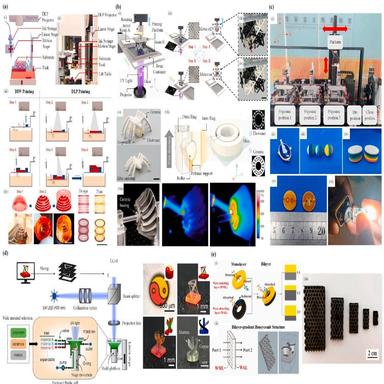
DLP-based multi-material ceramic additive manufacturing equipment and technologies: (a) multi-material 3D printing equipment integrating DLP and DIW technologies along with the printed multi-color structural parts, (b) DLP-based centrifugal multi-material 3D printing technology and heterogeneous ceramic prototypes, (c) multi-material ceramic additive manufacturing system along with printed multiple ceramic structures and ceramic-to-metal electronic parts, (d) dynam